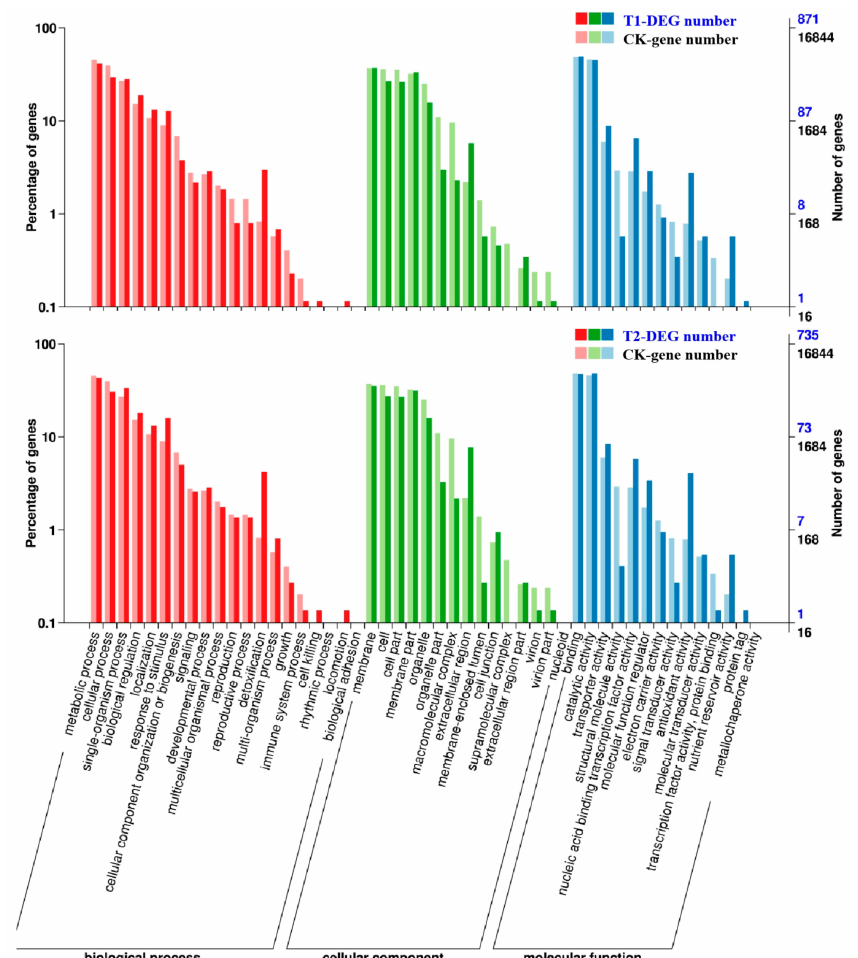
Figure 4. Functional classification and enrichment analysis of di ff erentially expressed genes (DEGs) in the gene ontology (GO) analysis. Significantly enriched GO classifications were analyzed using pairwise comparisons of T1 / CK and T2 / CK with the criterion of false discovery rate (FDR) ≤ 0.05. The DEGs were assigned into three classifications: Biological process, cellular components, and molecular function. The x -axis represents GO classifications, the y -axis on the left represents the DEGs that account for the percentage of every classification, and the y -axis on the right represents the amount of DEGs in each